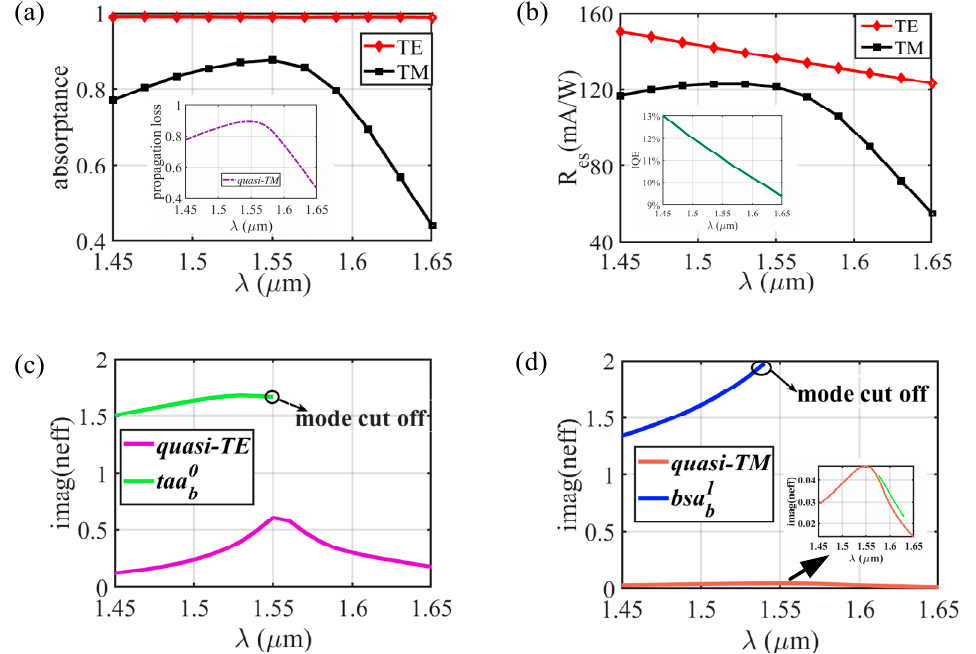
Figure 6. ( a ) Absorption rate and ( b ) responsivity of the dual-layer Schottky photodetector (PD) under TE and TM incidence versus wavelength. Other parameters: Au, h m = 6 nm, wt 1 = 0.07 µm, wt 2 = 0.082 µm, wb 1 = 0.17 µm, wb 2 = 0.182 µm, lt 1 = 0.2 µm, lt 2 = 0.5 µm, ls = 6 µm. Imaginary parts of ( c ) quasi-TE mode and taa b0 mode, ( d ) quasi-TM mode and bsa b1 mode in dual-layer type plasmonic waveguide versus wavelength when w t = 0.082 µm and w b = 0.182 µm.